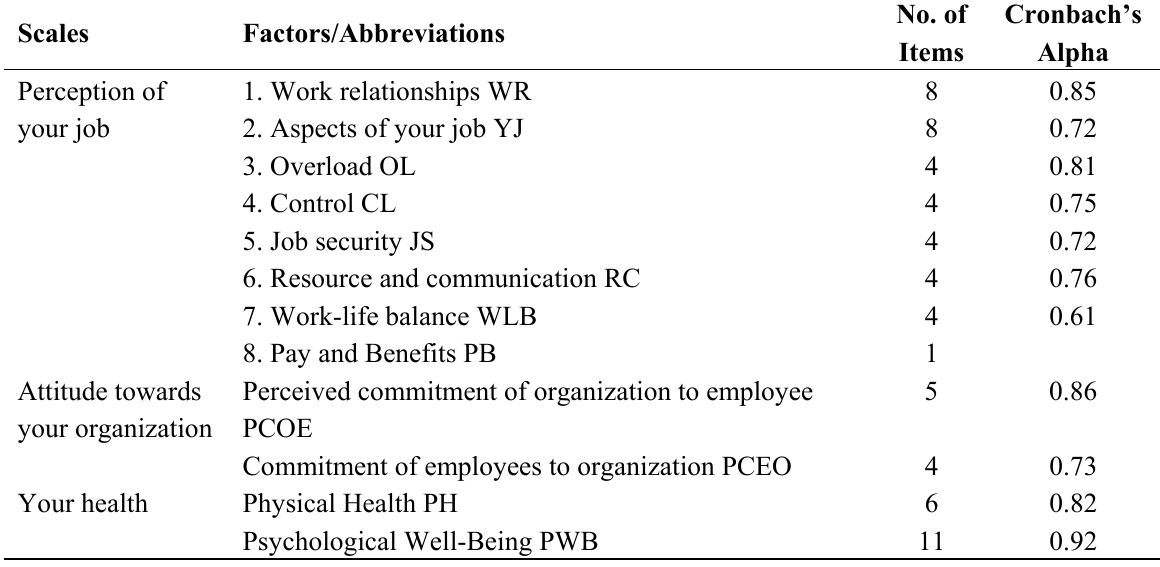
Table 1. Summary of ASSET sub-scales ( n =